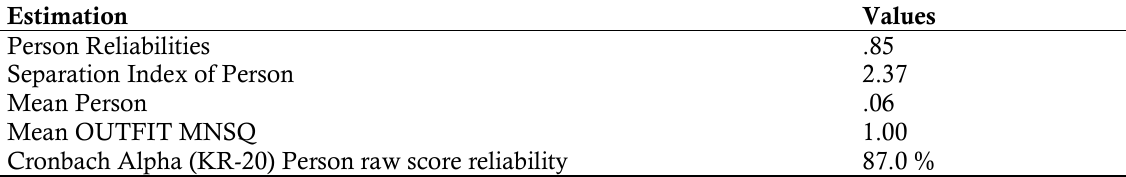
Table 2. Summary of quality